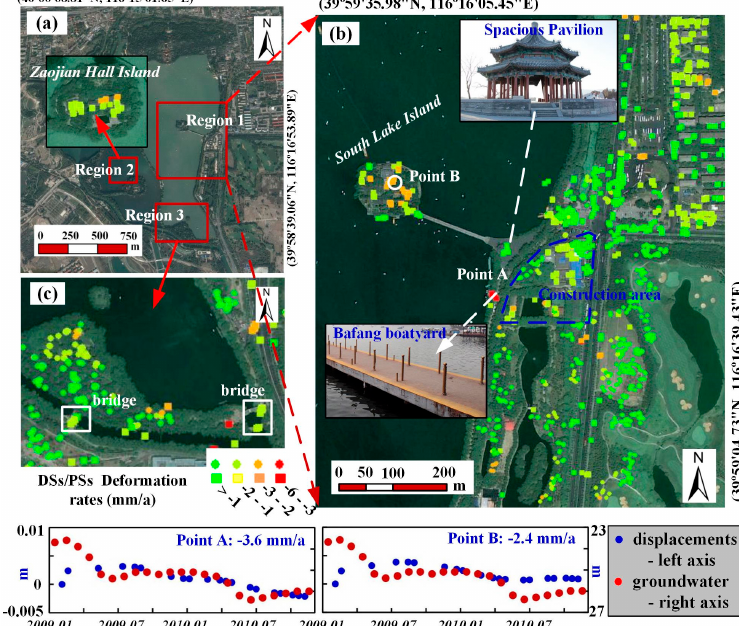
Figure 8. ( a ) Google Earth map of the study site and the deformation map of Zaojian Hall Island; ( b ) map of deformation rates in Region 1 and the displacement time series of Points A and B; and ( c ) map of deformation rates in Region 3. The graphs illustrate displacement evolution of Points A and B (blue dots) together with the change of groundwater level (red dots).